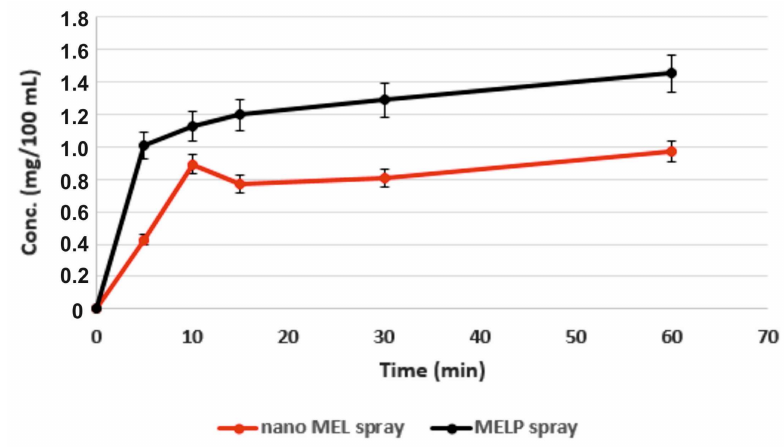
Figure 2. Extent of dissolution of MEL and MELP from nasal formulations at pH 5.60.